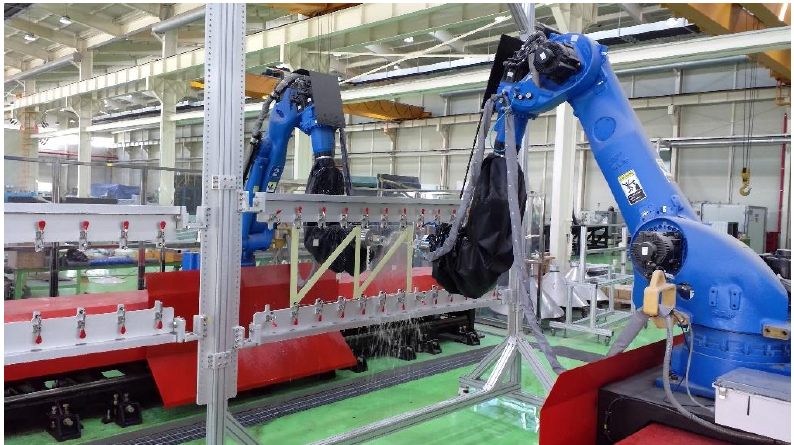
Figure 8. Scanning for reference specimens with artificial defects.